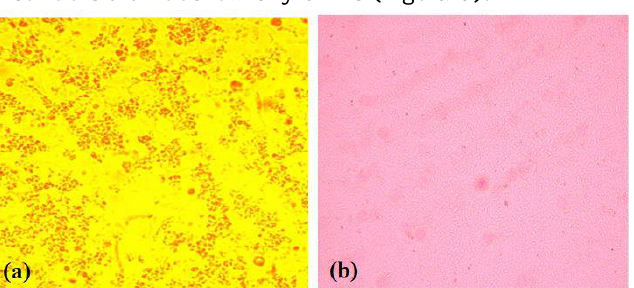
Fig.1: (a) shows the cytopathic effect of EHV-1 isolate on Vero cells in rounding and cell detachment (Mag. 10X). (b): Negative control of non-infected Vero